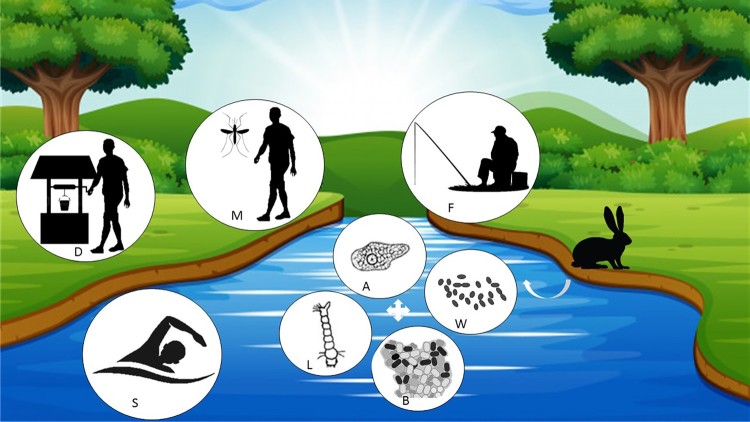
Potential aquatic sources of human infections with Francisella tularensis. Francisella tularensis is released into water from animals. The bacterium is able to survive in water (W), in mosquito larvae (L), in biofilms (B), or in cooperation with amoeba (A). Human can be contaminated from the aquatic reservoir by drinking contaminated water (D), after a mosquito bite (M), or during swimming (S) and fishing (F) activities.